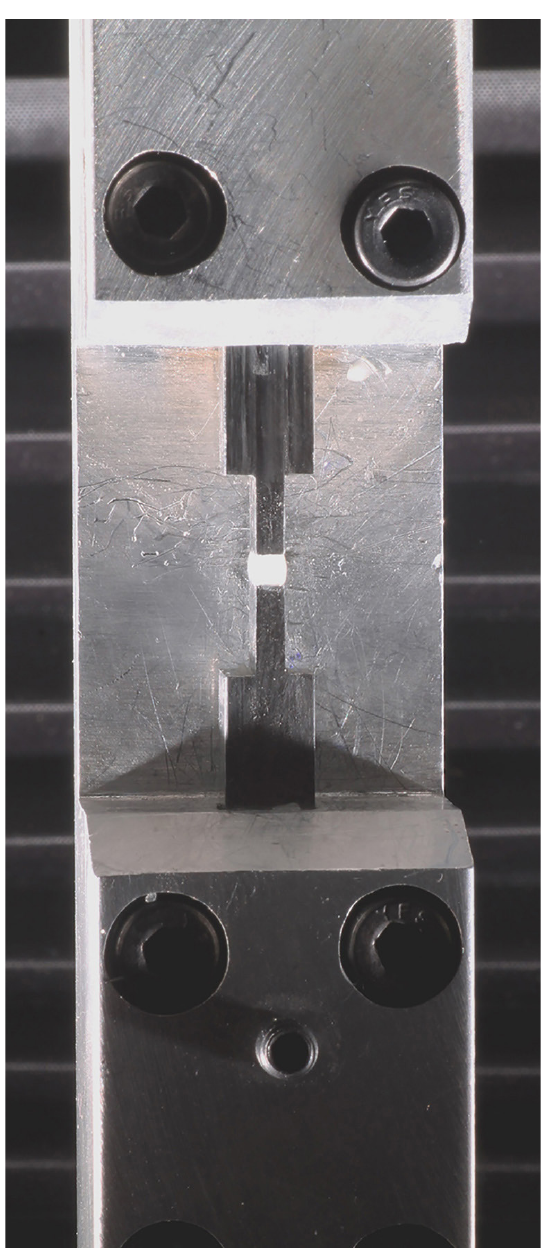
Figure 2- Universal Testing Machine (INSTRON) and metallic bases with composite specimen in